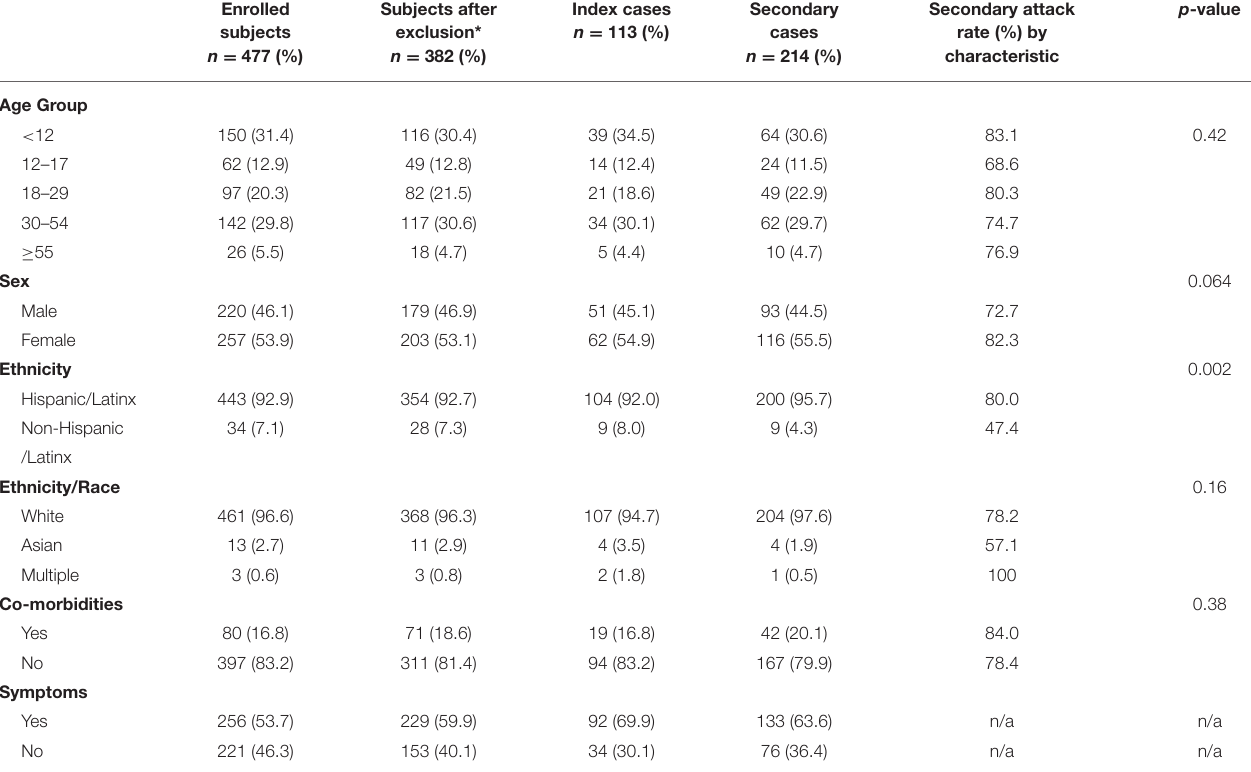
TABLE 2 | Characteristics of all enrolled subjects, index cases, and secondary cases and individual secondary attack rate of laboratory-confirmed SARS-CoV-2 infections among those at risk by characteristics, in household members enrolled in a prospective study of SARS-CoV-2 household transmission—Los Angeles,